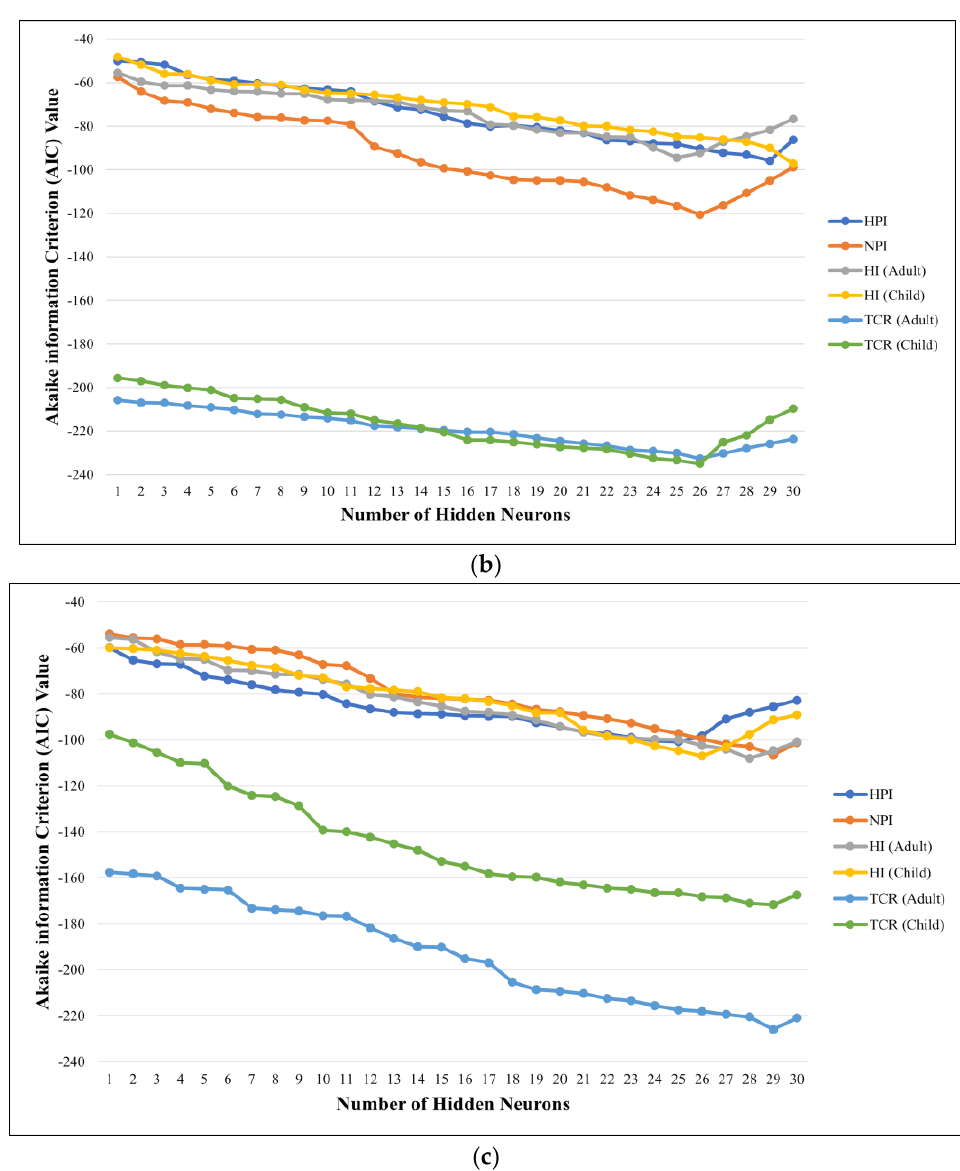
Figure 20. Akaike information criterion (AIC) values for pollution and risk indices in ( a ) TW, ( b ) GW, and ( c )